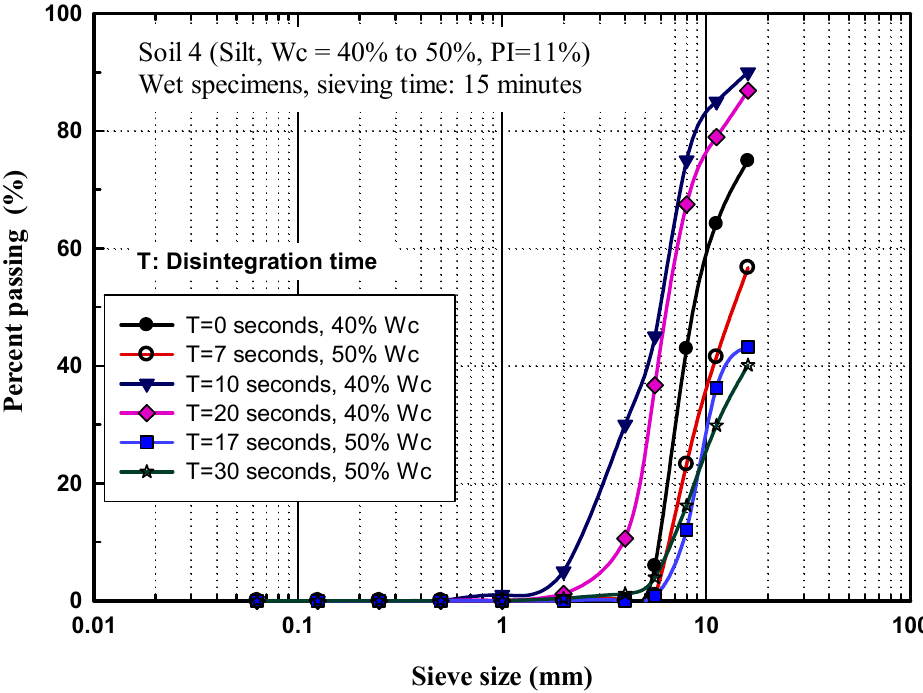
Figure 12. Pass percentage versus sieve size for wet specimens of Soil 4 prepared at different disintegration times with different initial water contents.